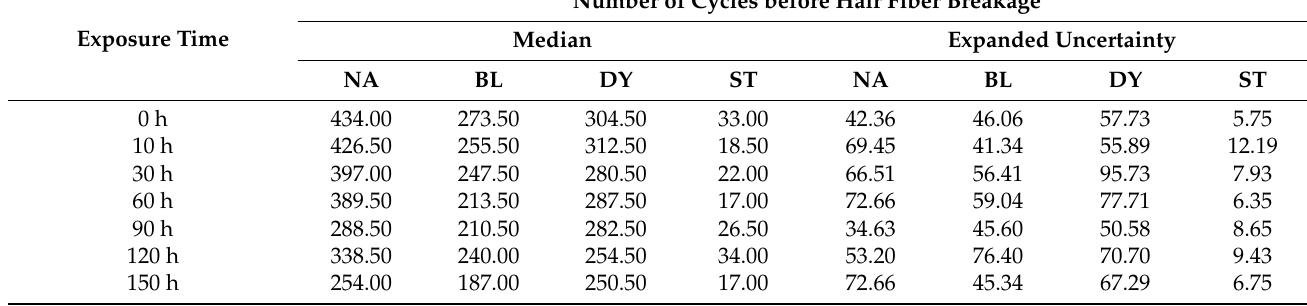
Table 3. Descriptive statistics of hair samples analyzed via the flexabrasion method, expressed as the number of cycles before shaft breakage.